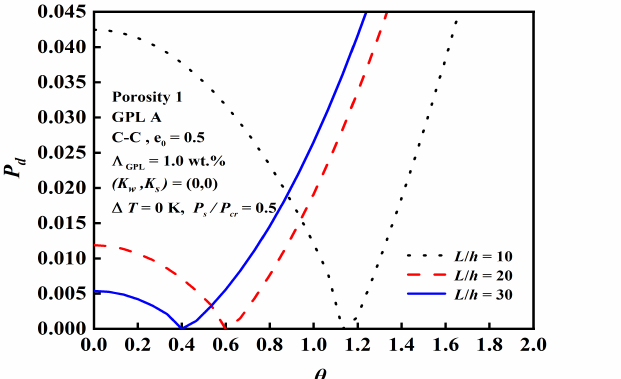
Figure 16. Effect of the slenderness ratio L / h on dynamic instability.